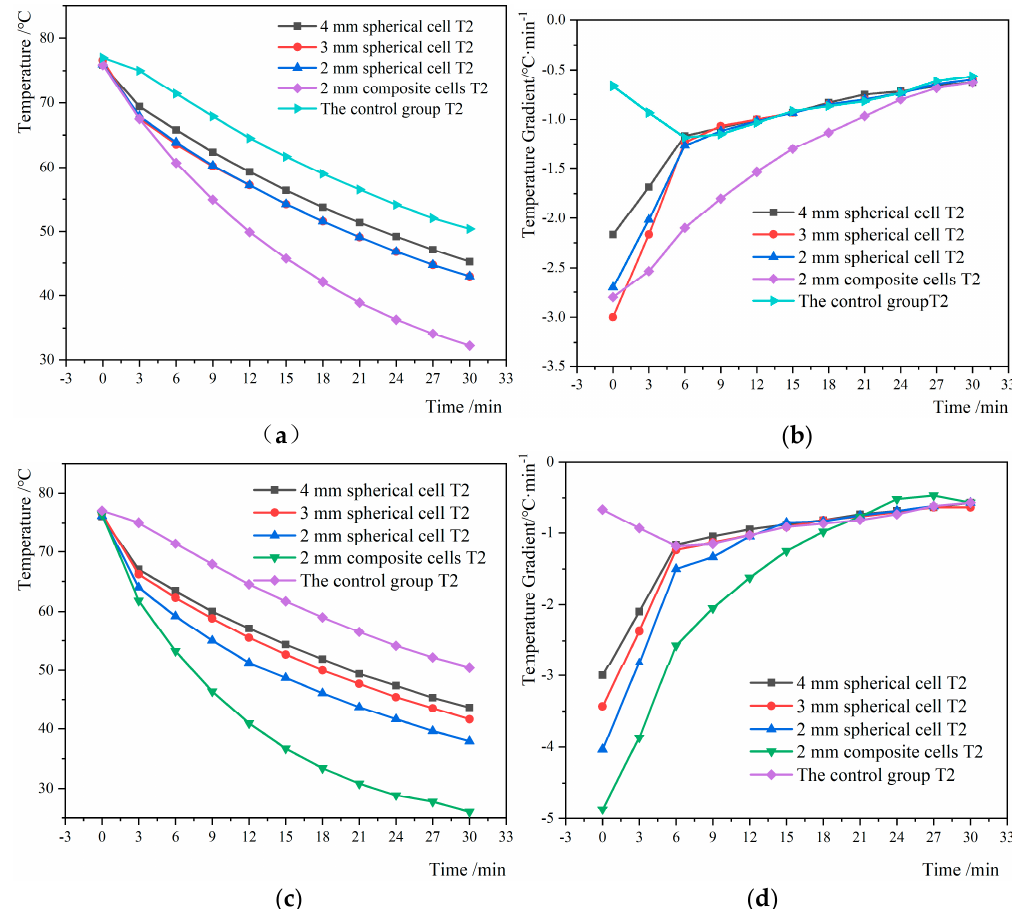
Figure 9. Metal foam forced convection heat dissipation curve. ( a ) Aluminium foam heat dissipation curve. ( b ) Temperature gradient of aluminium foam heat dissipation curve. ( c ) Copper foam heat dissipation curve. ( d ) Temperature gradient of copper foam heat dissipation curve.